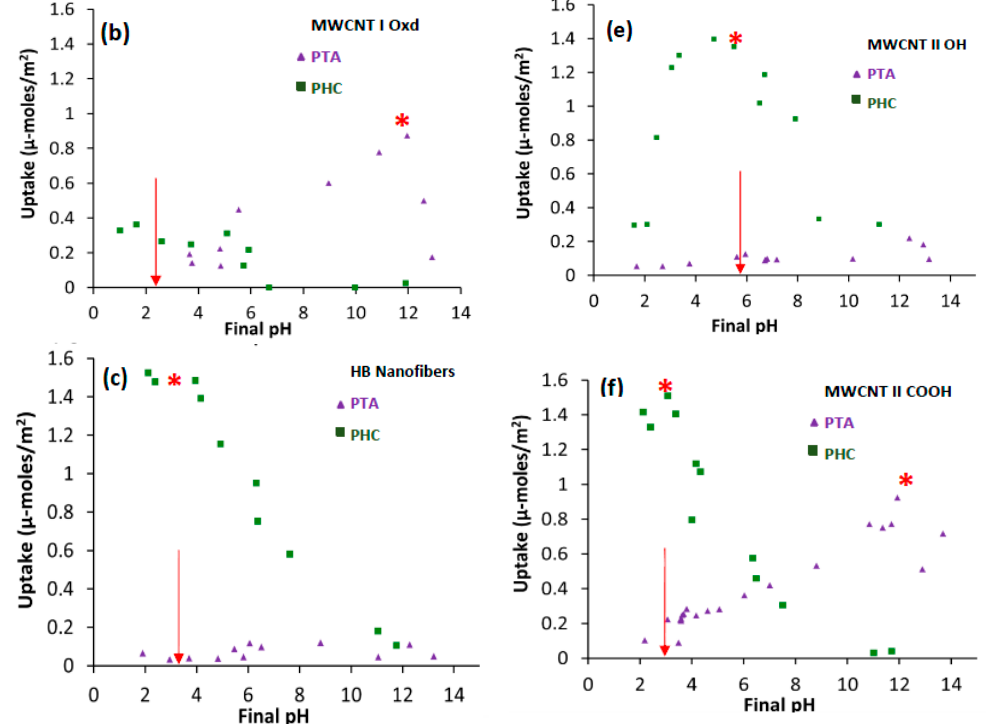
Figure 2. Uptake plots using Pt (II) tetraammine (PTA) and Pt (IV) hexachloride (PHC) for: ( a ) MWCNT I; ( b ) MWCNT I Oxd; ( c ) HB Nanofibers; ( d ) MWCNT II; ( e ) MWCNT II OH; and ( f ) MWCNT II COOH. Asterisks indicate pH of large batch preparation.